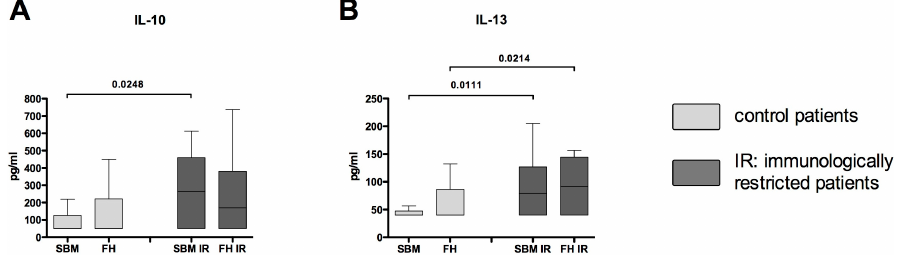
Figure 3. Regulatory cytokines are increased in FH/SBM of immunologically restricted patients. Supernatants from FH and SBM of immunologically restricted patients (FH IR/SBM IR: dark grey) and controls (FH/SBM: light grey) were analyzed for the concentrations of regulatory cytokines via multiplex suspension array. ( A ) IL-10; ( B ) IL-13. Controls n = 42, IR patients n = 20. IR-patients vs. controls Mann-Whitney U test, FH vs. corresponding SBM Wilcoxon test, p -values < 0.05 are shown as numbers in the Figure.